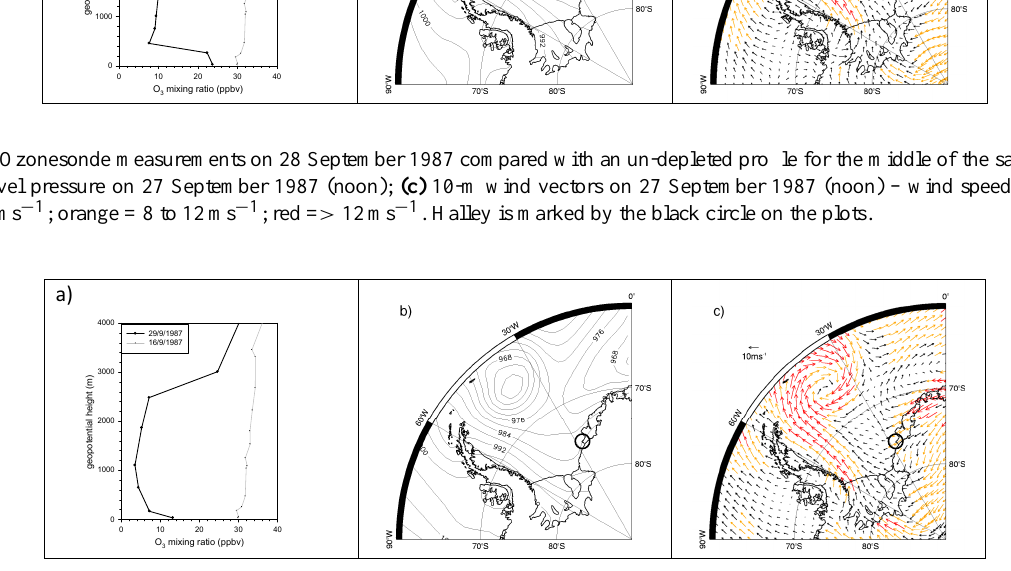
Fig. 16. (a) Ozonesonde measurements on 29 September 1987 compared with an un-depleted profile for the middle of the same month; (b) mean sea level pressure on 29 September 1987 (noon); (c) 10-m wind vectors on 29 September 1987 (noon) – wind speeds identified as: black = < 8ms − 1 ; orange = 8 to 12ms − 1 ; red = > 12ms − 1 . Halley is marked by the black circle on the